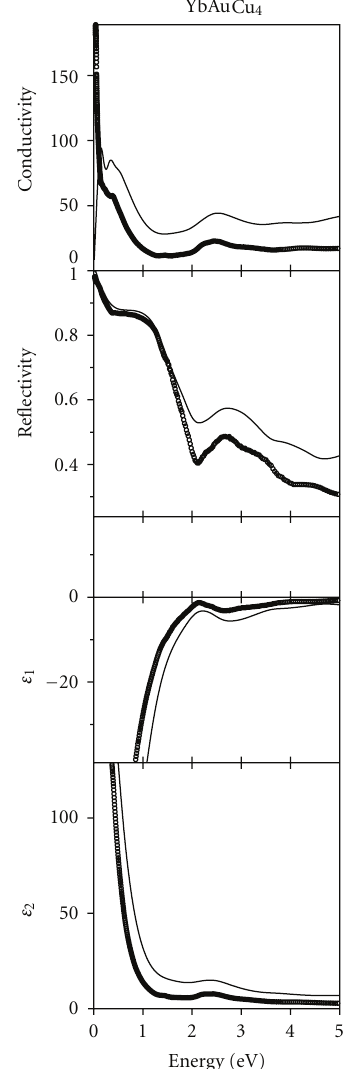
Figure 104: Comparison between the experimental (dots) and LSDA+ U calculated (solid line) optical spectra of YbAuCu 4